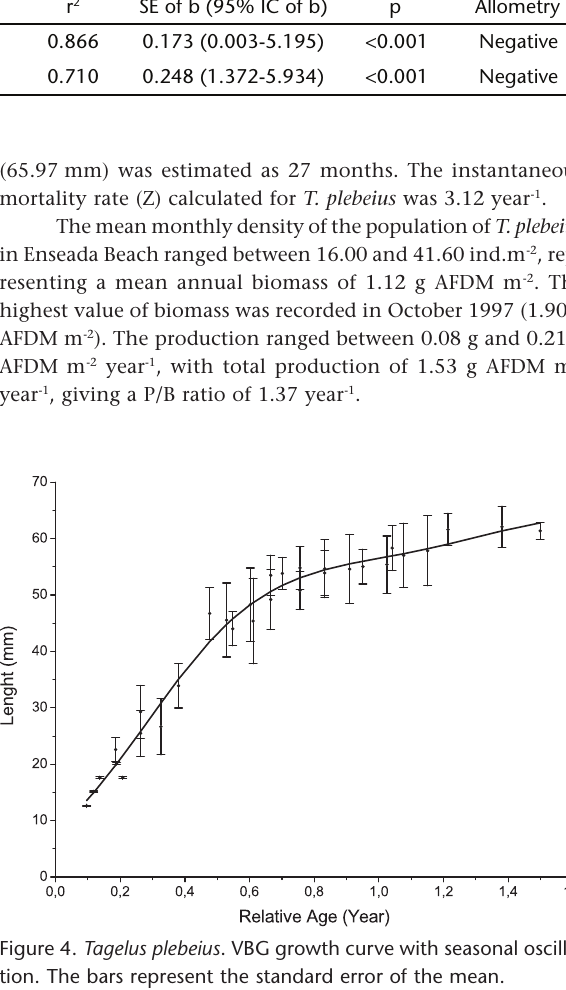
Table I. Tagelus plebeius . Descriptive statistics and parameters of the relation mass/length of the population of Enseada beach. (N) Number of individuals, (r 2 ) determination coefficient, (SE of b) standard error of b, (IC) range of confidence, (p) probability. Regression